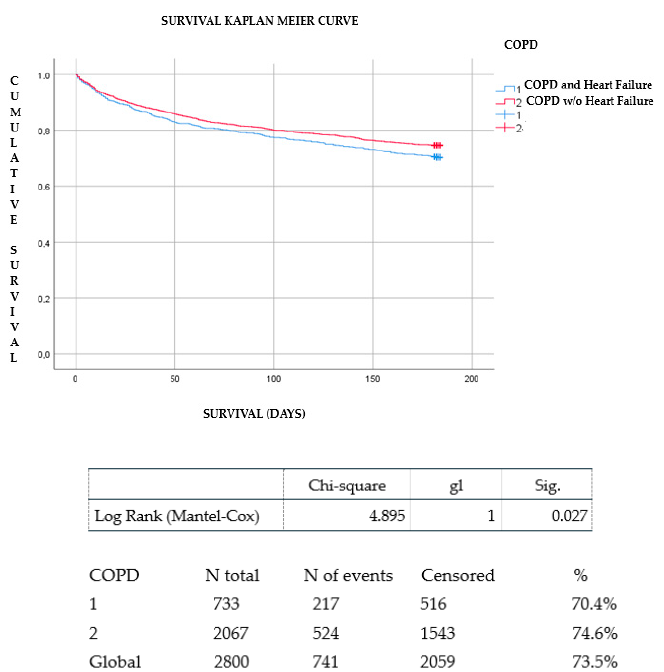
Figure 1. Kaplan–Meier survival curve between HF patients with and without